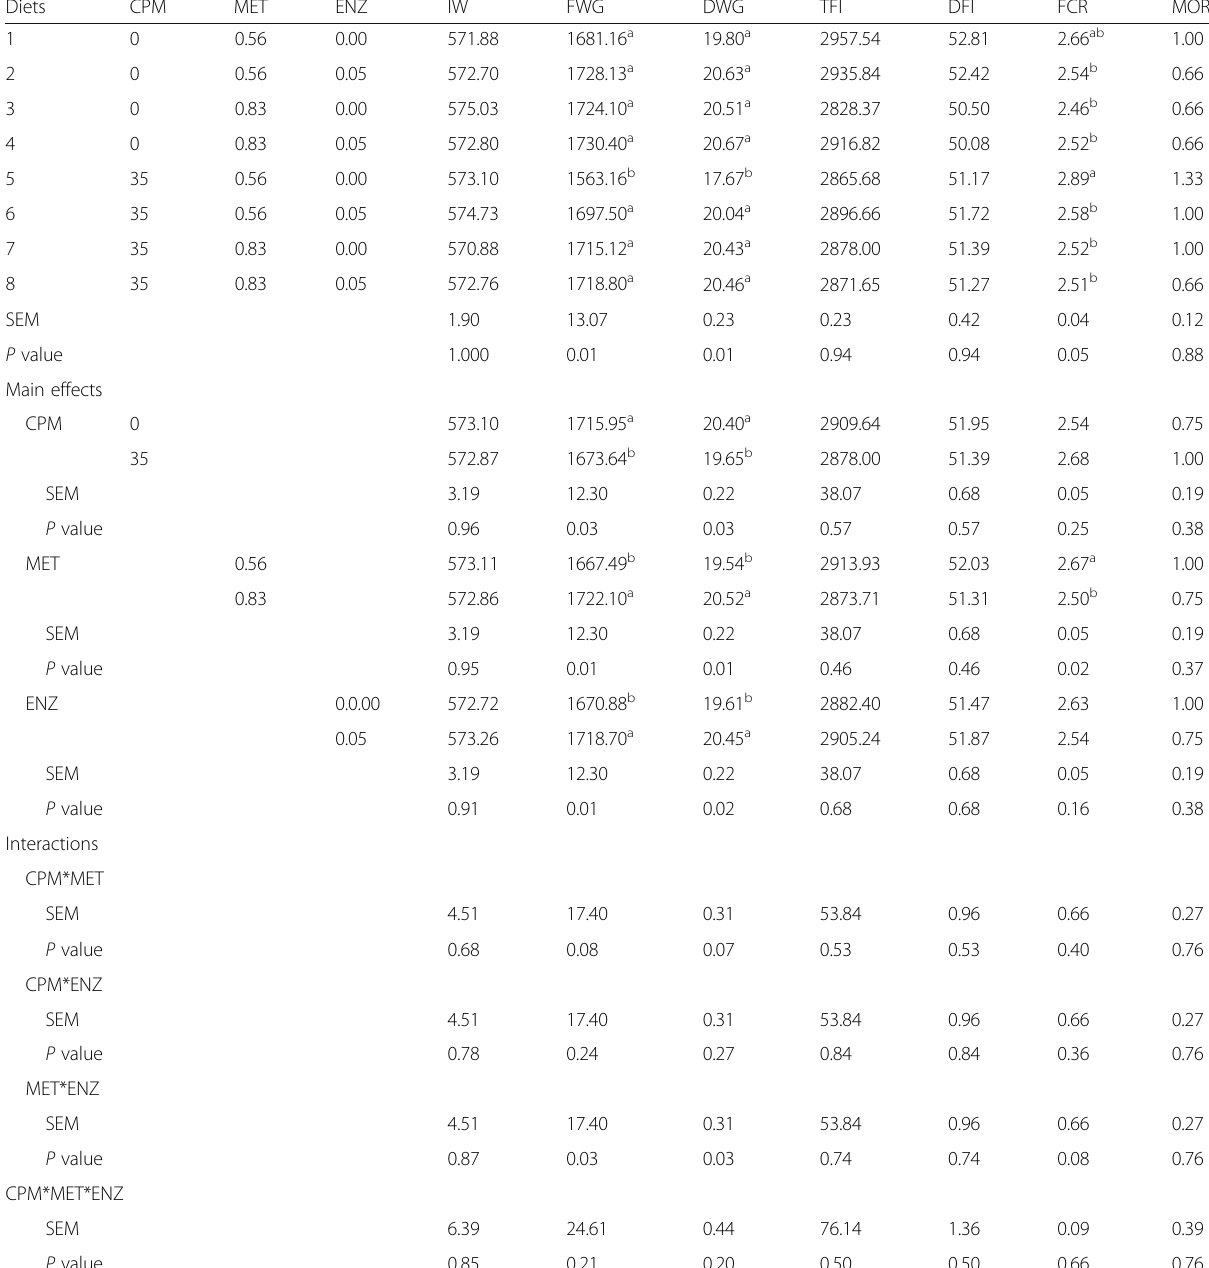
Table 3 Effect of cassava peel meal inclusion (%), methionine (%), and multi-enzyme (%) supplementation on growth performance in